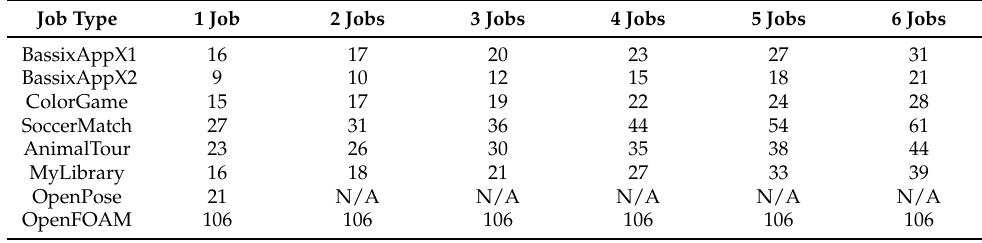
Table 6. Increasing CPU time at PC6